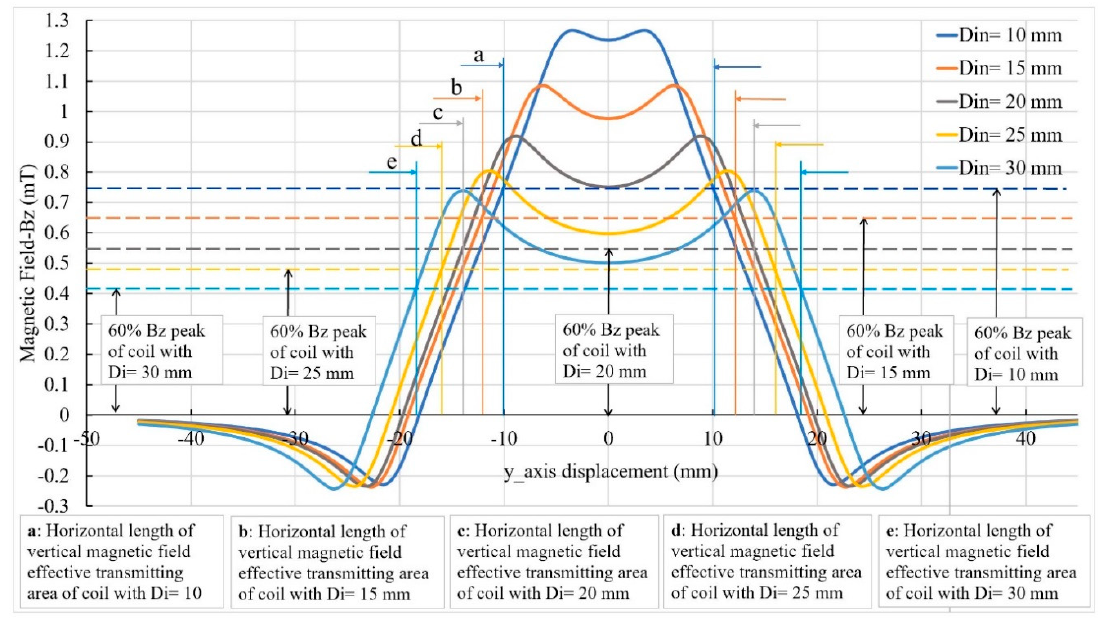
Figure 7. The vertical magnetic field distribution characteristic curve of evaluated coils along the y-axis. The Bz distribution characteristic curve and the magnetic field effective coverage area detail for every evaluated coil are shown in Figure 8.